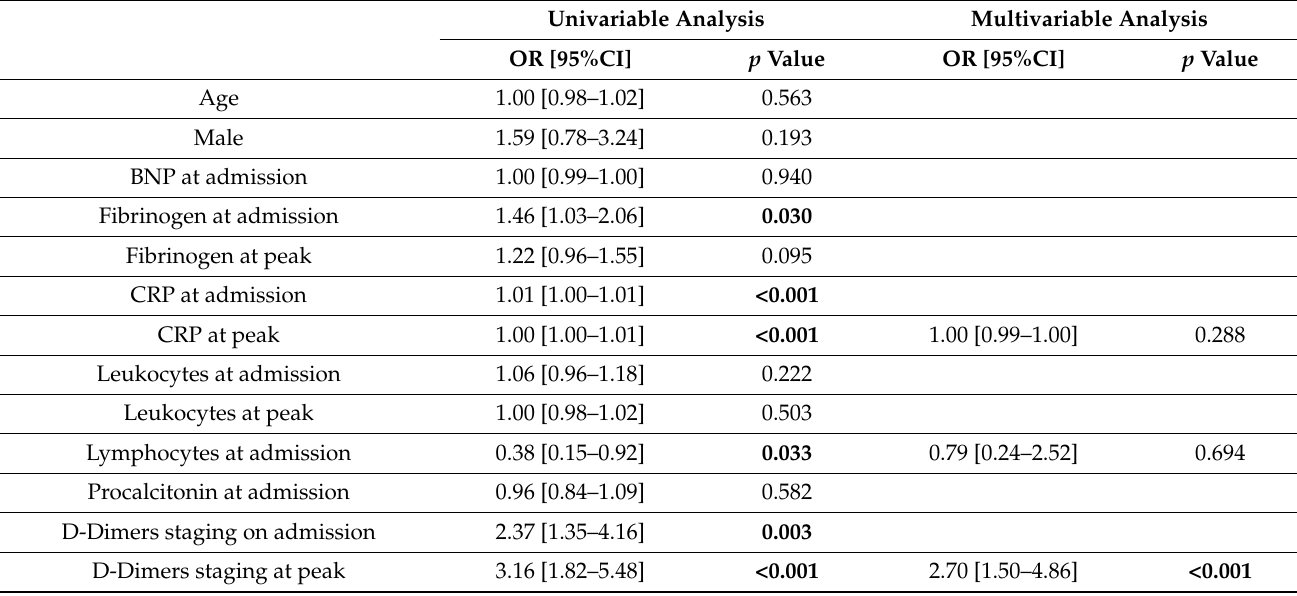
Table 4. Predictive factors of critical lung injury in COVID-19